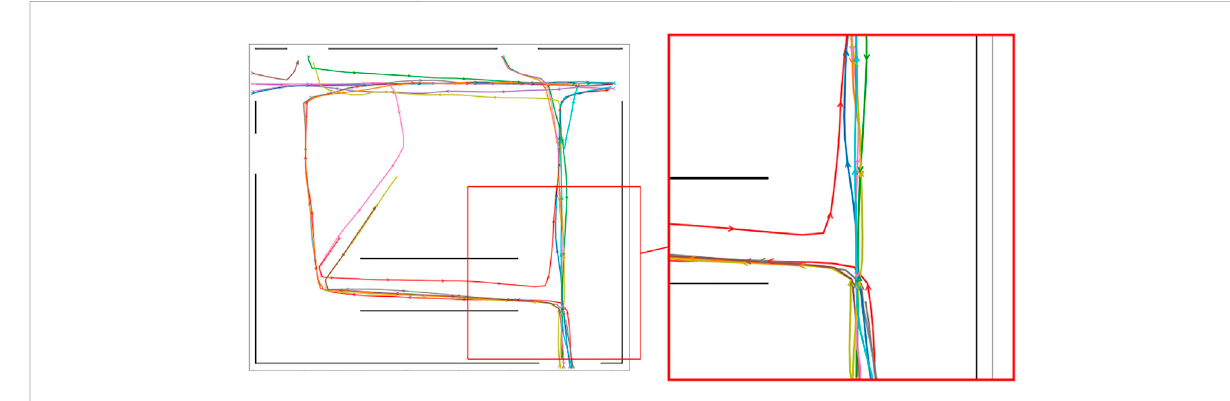
FIGURE 5 Pedestrian paths from time-point t1 used for execution phase experiments in the warehouse environment.